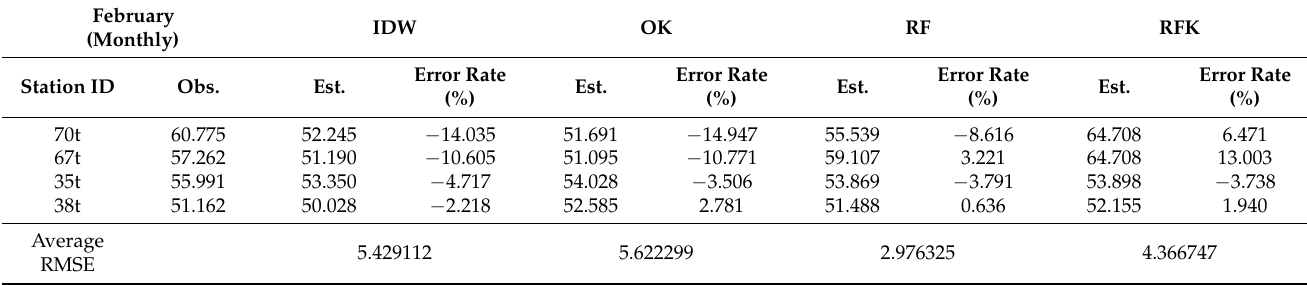
Table 5. Test station-based comparison between observations and estimates from interpolation models with observed concentration over 50 µ g/m 3 from a monthly dataset in February.